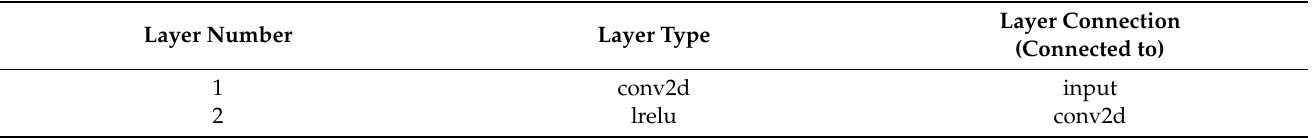
Table 8. Description of a convolution block of the discriminator.